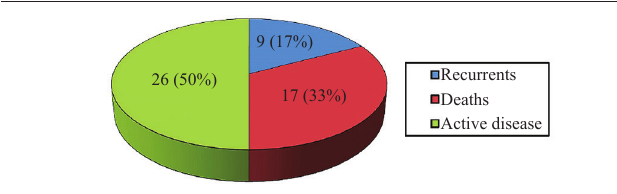
figuRE 1 − Patients with MM (n = 52) included in the study. Progress during the period from January 2012 to July 2014: death, response to treatment with relapse and active disease with no appropriate therapeutic response MM: multiple